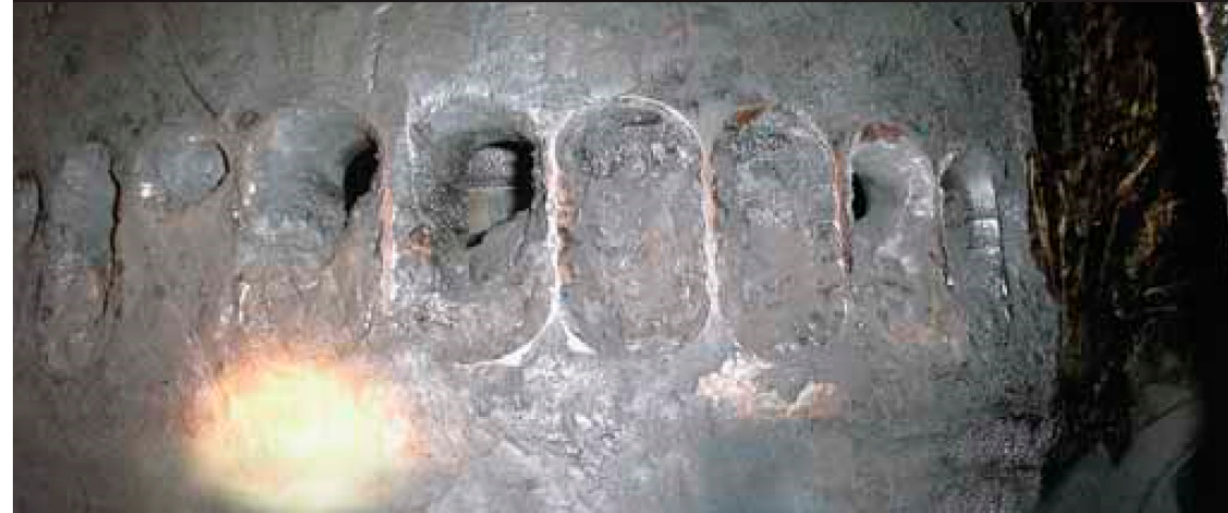
Figure 1. View of contaminated scavenging ports in the sleeve of cylinder No. 2 of the main engine of the m/v Goliath (Australian Transport Safety Bureau, 2006).